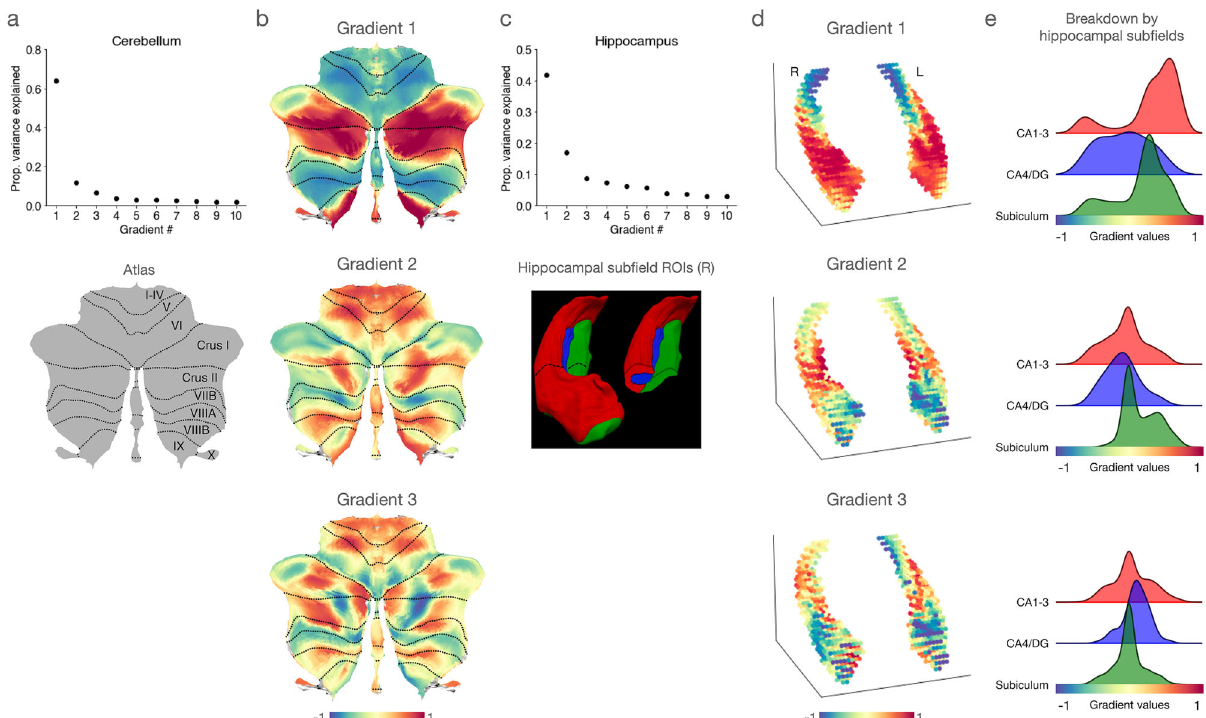
Fig. 1 Functional connectivity gradients of the cerebellum and the hippocampus in relation to the isocortex in humans ( n = 1003). a The scree plot illustrates the proportion of variance explained by each of the ten functional connectivity gradients derived from intrinsic connectivity between the cerebellum and the isocortex. The fl atmap as a reference of the cerebellar lobules was reproduced from ref. 38 with permission. b The three most dominant gradients of cerebellar-isocortical connectivity . c The scree plot illustrates the proportion of variance explained by each of the ten functional connectivity gradients derived from the intrinsic connectivity between the isocortex and the hippocampus (top). A fi gure illustrating the sub fi elds in the right hippocampus (red = CA1 – 3, blue = CA4-DG, green = subiculum) was reproduced from ref. 58 with permission. d The three most dominant gradients of the hippocampal-isocortical connectivity. e The ridge plot depicts the distribution of gradient values per hippocampal sub fi eld